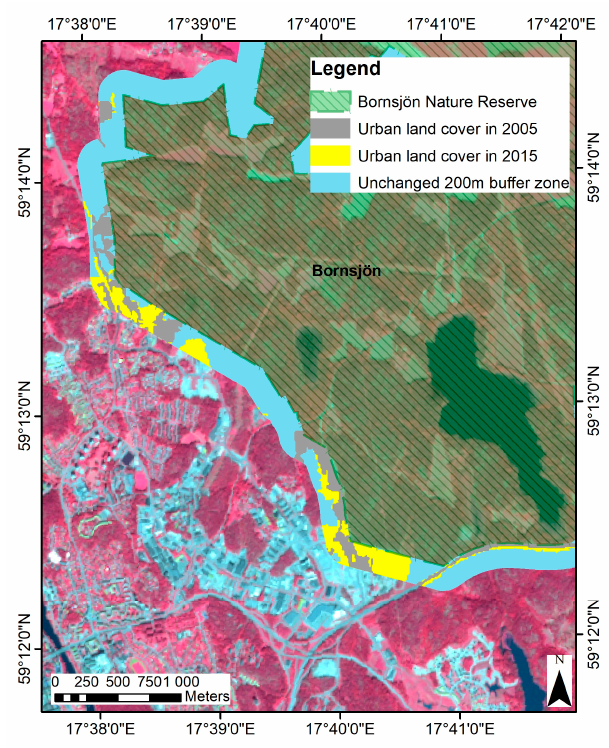
Figure 8. Increase in urban land cover within 200 m of Bornsjön Nature Reserve in Södertälje Municipality between 2005 and 2015.